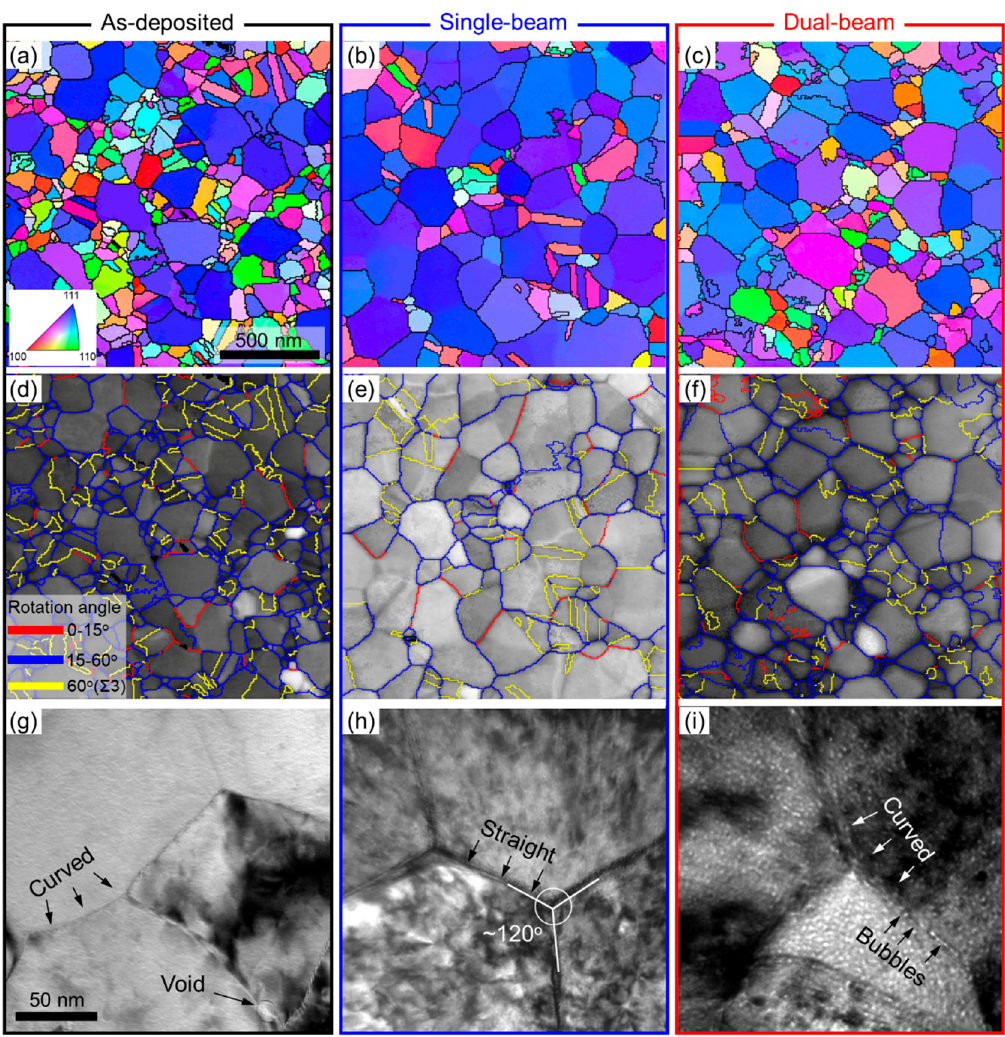
Figure 3. Microstructural characterization of as-deposited ( a , d , g ), single-beam irradiated ( b , e , h ), and dual-beam irradiated samples ( c , f , i ). ( a – c ) Crystal orientation maps obtained from ASTAR system. ( d – f ) Grain boundary maps superimposed upon image quality maps. ( g – i ) TEM micrographs showing enlarged views of representative GBs.